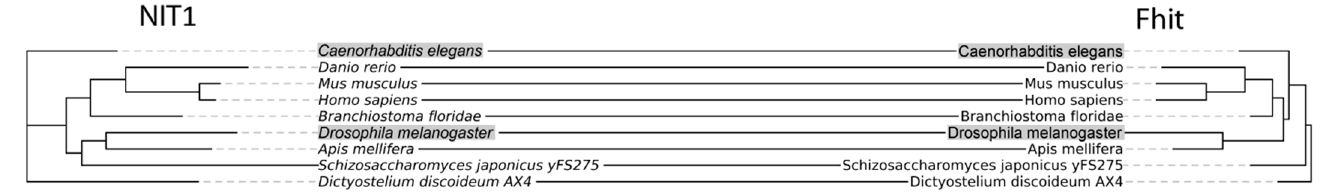
Figure 2. Co-evolution analysis of Nit1 and Fhit homologues genes by tanglegram-approach shown for a selected group of proteins. Fusion proteins are shaded in grey. For the complete analysis see Appendix A Figure A1A,B.